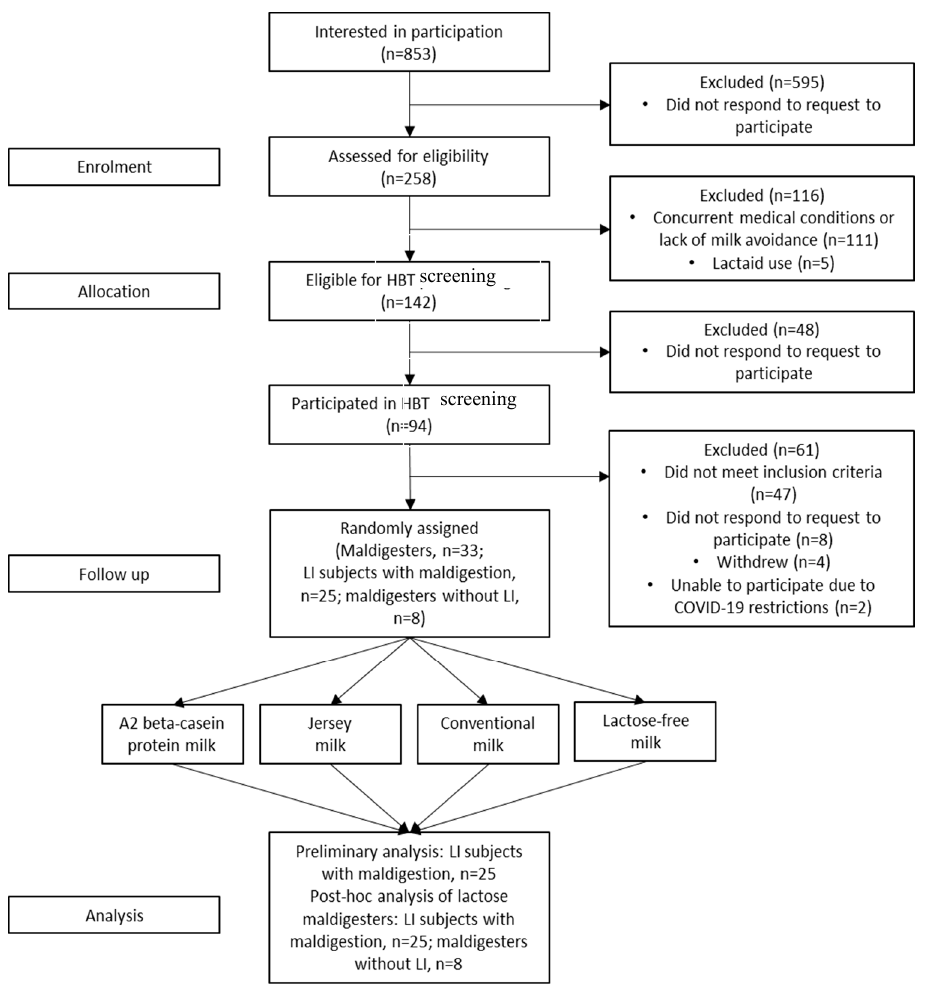
Figure 1. Study enrollment, randomization and analyses. HBT, hydrogen breath test; LI, lactose intolerance/intolerant.